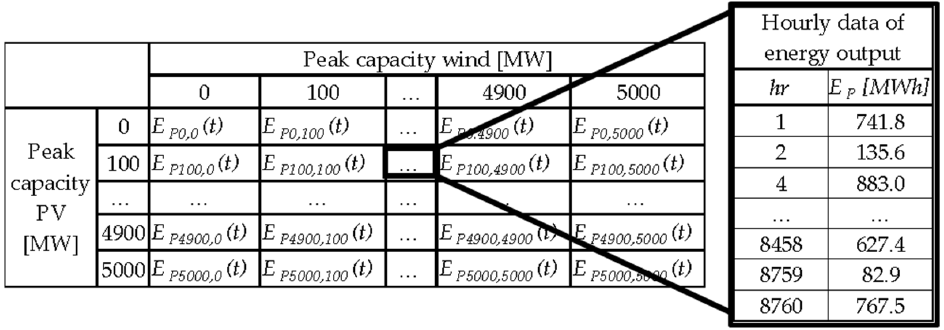
Figure 2. The combination of wind and PV ‘base’ systems that were evaluated to optimize the energy output from the generators.